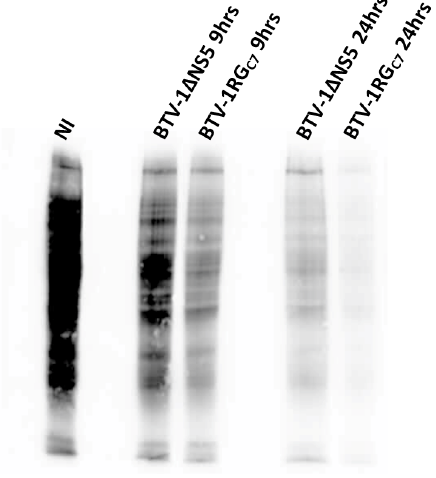
Figure 16. Pulse and chase puromycin labelling of cells infected with BTV-1RG C7 or BTV-1 ∆ NS5. BSR cells infected with BTV-1RG C7 or BTV-1 ∆ NS5 were pulse-labelled with puromycin for 15 min at 9 or 24 h post-infection (as indicated), then harvested 3 h later. Western blot analysis was per- formed using a monoclonal anti-puromycin antibody. NI indicates analysis of non-infected cells.